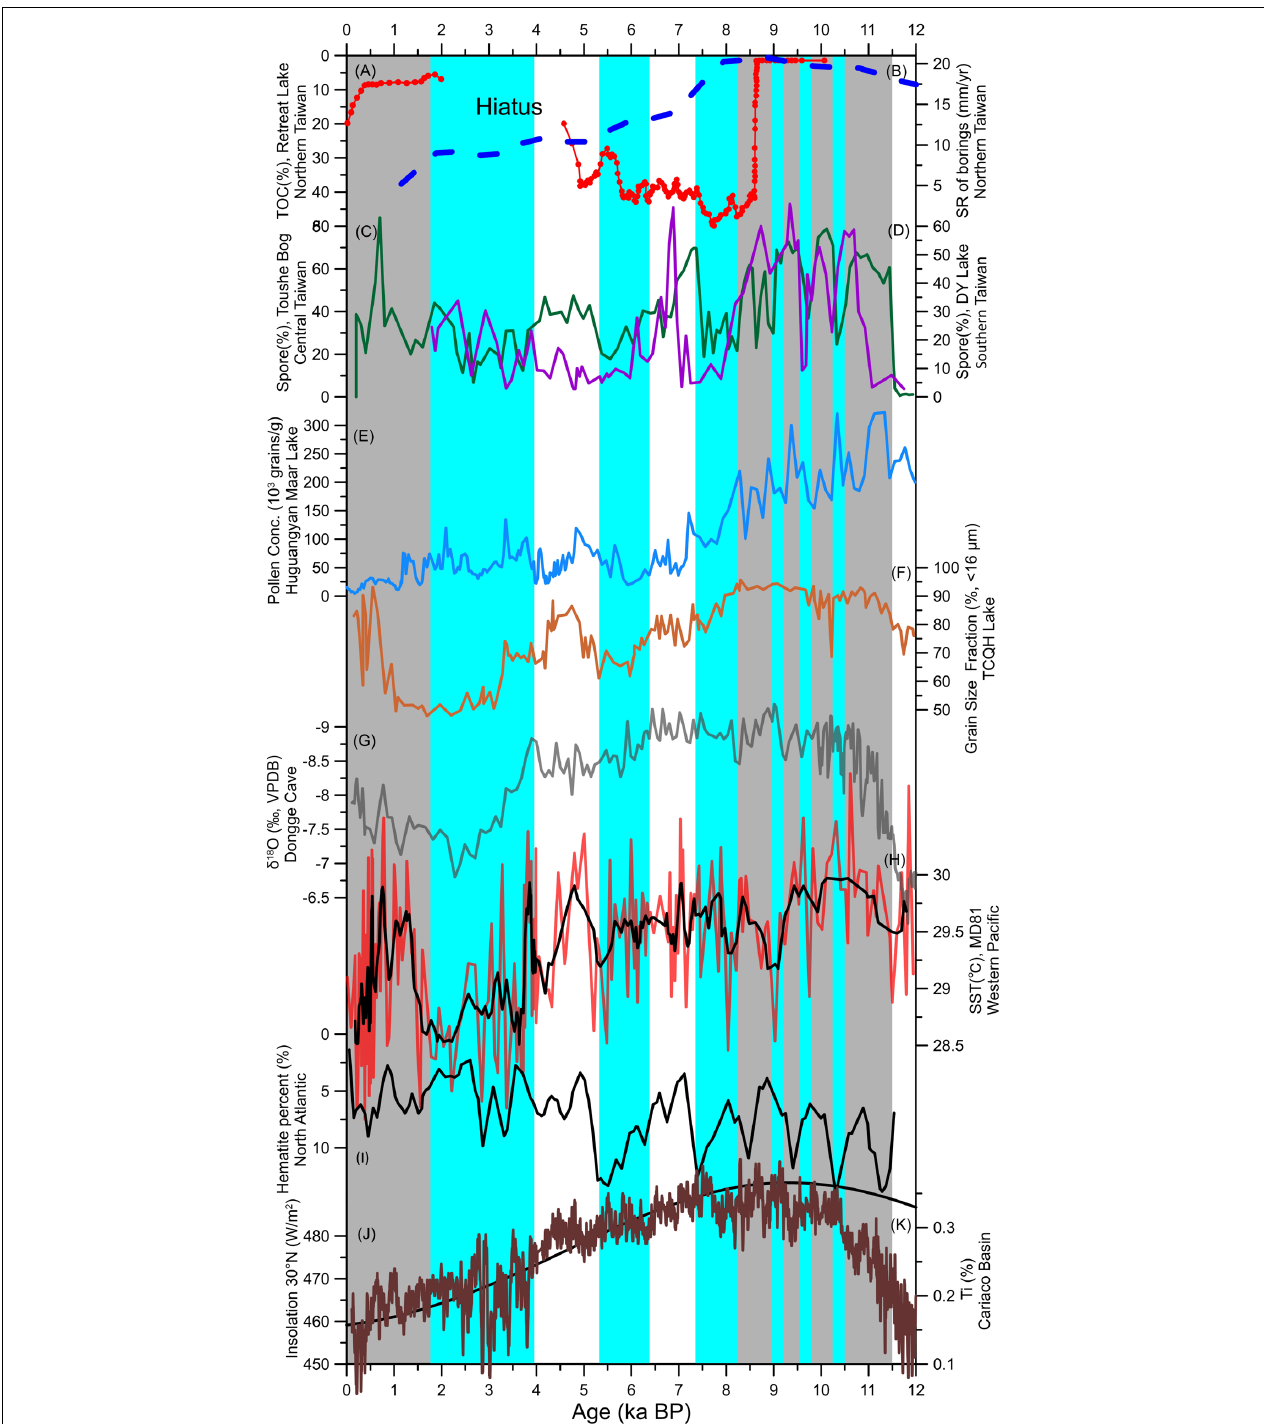
FIGURE 3 | Comparisons of paleoclimate records from Taiwan (A–D) with regional and global climatic records (E–K) . (A) TOC record from Retreat Lake (Selvaraj et al., 2011). (B) Variations in sedimentation rate from on-land cores in northern Taiwan (The blue dashed line, Wu, 2013). (C) Record of spore percentage from Toushe Basin (The purple line, Liew et al., 2006). (D) Record of spore percentage from Dongyuan Lake (The green line, Lee and Liew, 2010). (E) Variations in pollen concentrations from Huguangyan Maar Lake (Wang et al., 2016). (F) Small grain size contents from Tengchongqinghai Lake. (G) Speleothem δ 18 O records from Dongge (Dykoski et al., 2005). (H) SST records from the MD81 site in the western tropical Pacific (Stott et al., 2004). (I) Hematite percentages in the North Atlantic (Bond et al., 2001). (J) Summer insolation at 30 ◦ N (The black line, Berger and Loutre, 1991). (K) Ti records from the Cariaco Basin, off the coast of Venezuela (The brown line, Haug et al., 2001). The gray bars highlight the early Holocene rainfall maximum and the “2-ka shift.” The cyan bars indicate dry events.